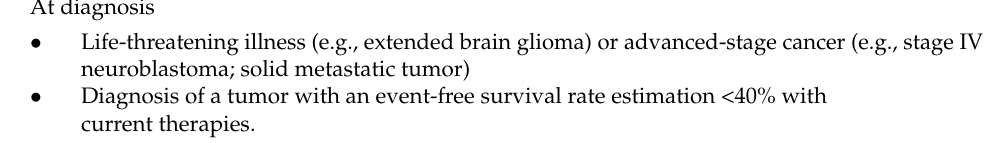
Table 1. “Green lights” to consider for the request of specialized PPC for children with